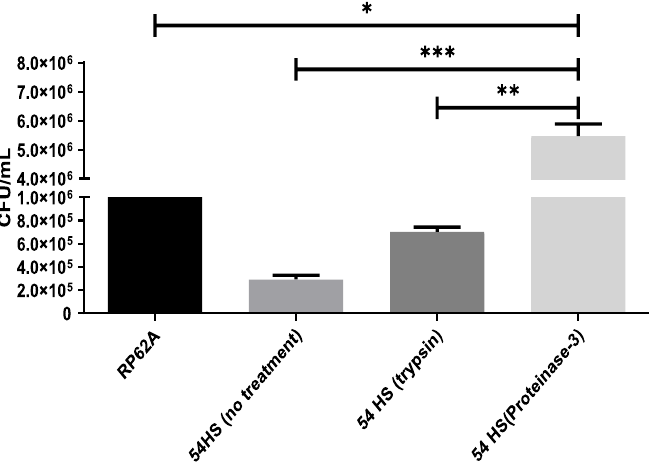
Figure 5. Assay of protease inhibition in the biofilm formation kinetics in isolate 54HS. Proteinase-3 was added to the kinetics from the beginning, and in addition 5 mM PMSF (a proteinase-3 inhibitor) was incorporated to the kinetics at 6 or 10 h after the starting point of culture in the isolate 54HS. The abundance of biofilm was determined according to Christensen et al. sampling at different points of the kinetics. Asterisk * indicates a significant difference ( p < 0.05) compared to the bacteria with proteinase-3 since the beginning. The statistical analysis was performed using a one-way ANOVA with Tukey’s test.